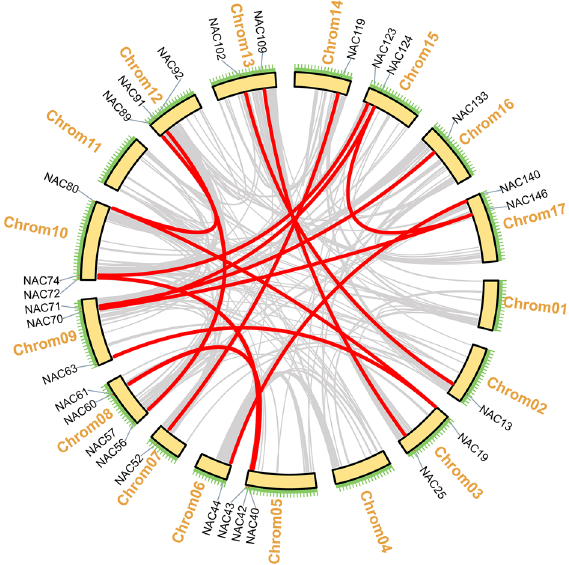
Figure 4. Syntenic analysis of the HaNAC s. The yellow box represented the chromosome, the line indicated the position of the syntenic gene pair on the chromosome, the red line denoted the HaNAC gene pairs, while the gray line showed other syntenic gene pairs in the sunflower.